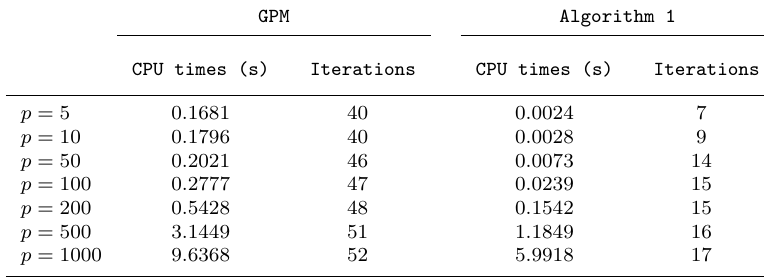
Table 3. Comparison of algorithms in Example